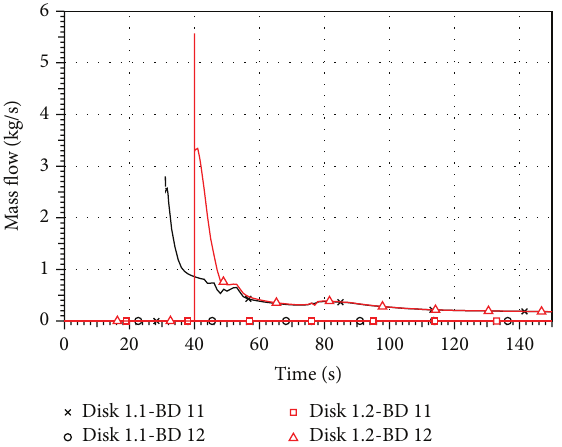
Figure 15: Temperature of outside environment 0 ∘ C: pressure in the nodes.